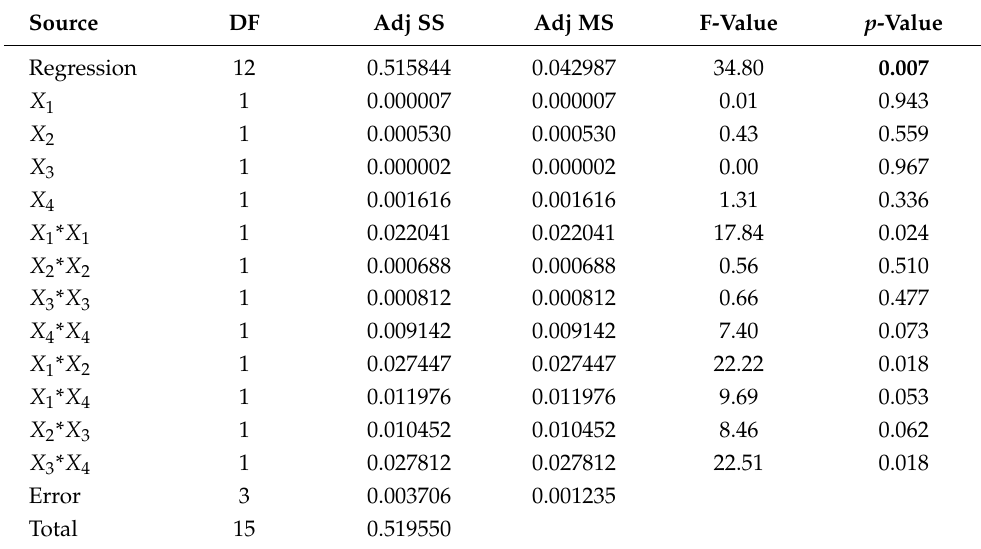
Figure 7. Scatter plot of forming parameters against measured surface roughness ( a ) X 1 X 2 X 3 vs. Roughness ( µ m); ( b ) X 2 X 3 X 4 vs. Roughness ( µ m); ( c ) X 3 X 4 X 1 vs. Roughness ( µ m); ( d ) X 4 X 1 X 2 vs. Roughness ( µ m). Table 8. Analysis of variance (ANOVA) table for surface